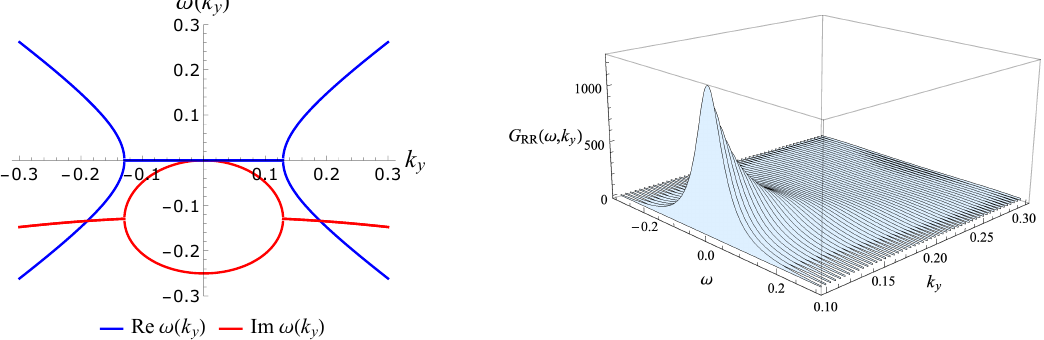
Figure 2: The dispersion relation (30) (left) and the symmetric Green’s function (28) (right) of the NG mode in the thin-wall regime with ( γ , β , A , m ) = ( 0.25,0.5,1.0,1.0 )